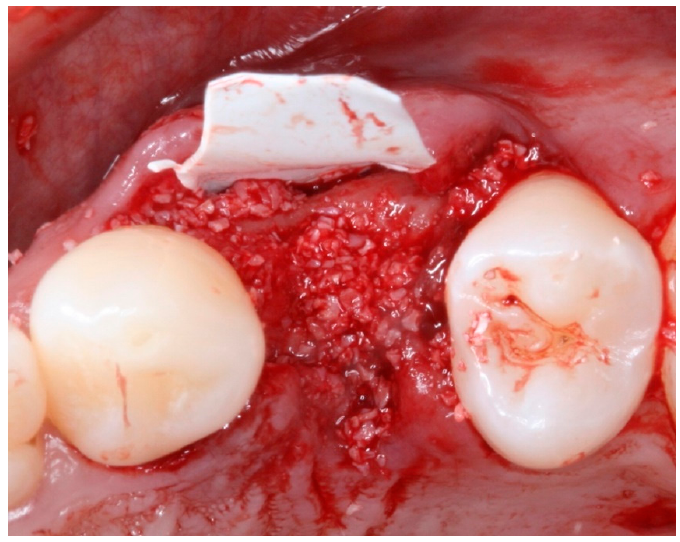
Figure 8. Intraoral occlusal view of the position of the d-PTFE and with the placement of the xenograft biomaterial in the socket of tooth 24